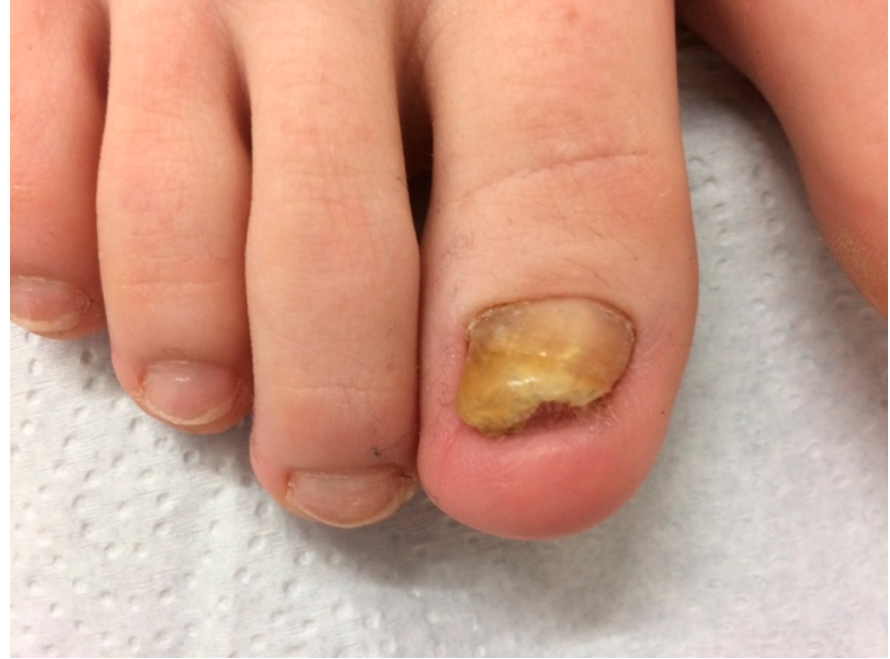
Figure 3. Post-traumatic single-digit onychomycosis of the big toe in a 28-year-old woman.